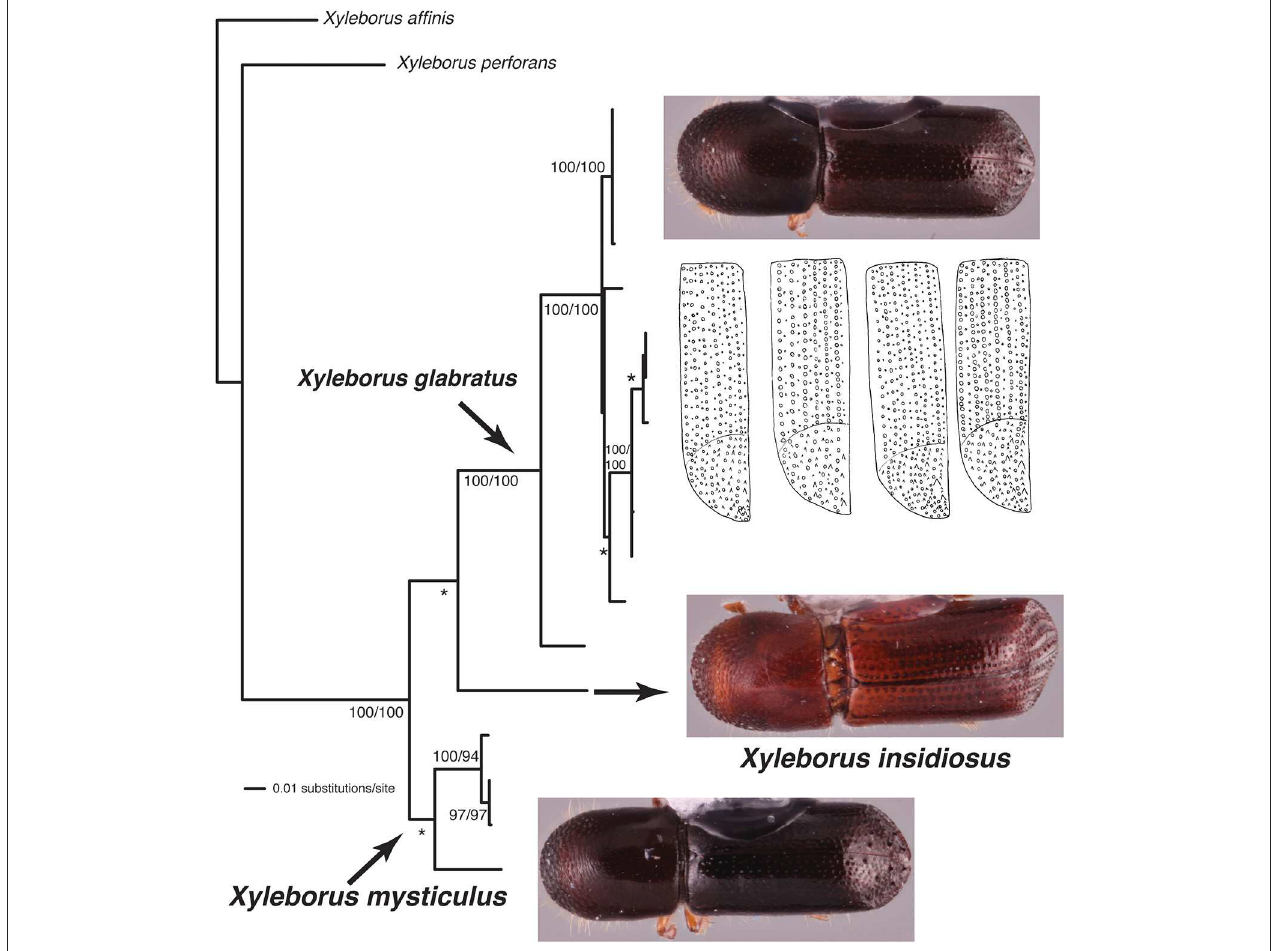
FIGURE 6 | Phylogeny of Xyleborus glabratus redrawn from Cognato et al. (2019). Habitus images depict intra- and interspecific morphological variation observed among granules of the elytra. Numbers at nodes indicate parsimony/likelihood bootstrap values and *bootstrap values <